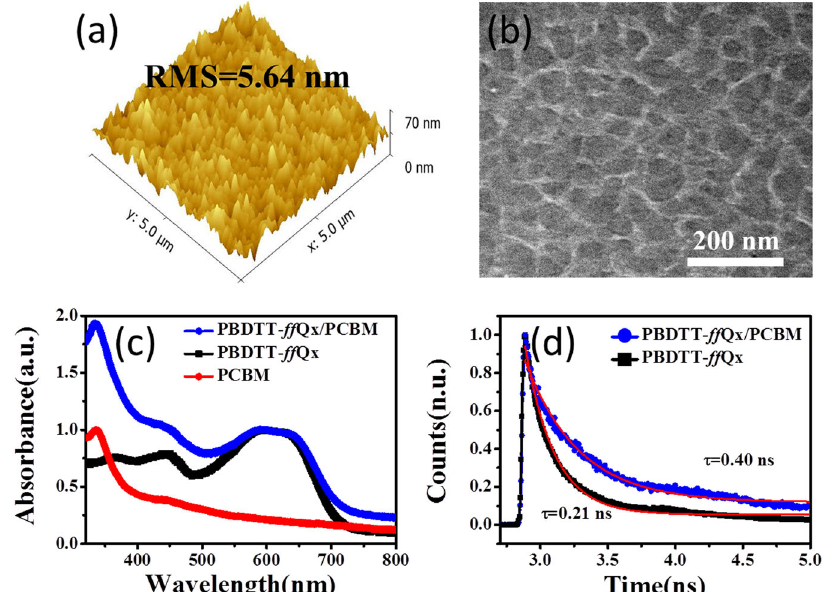
Fig. 2 a AFM and b TEM images of PBDTT- ff Qx/PCBM BHJ thin fi lm. c UV – vis absorption spectra of PBDTT- ff Qx (black), PCBM (red), and PBDTT- ff Qx/PCBM BHJ (blue) thin fi lms, respectively. d The PL time decay traces of PBDTT- ff Qx and PBDTT- ff Qx/PCBM BHJ thin fi lms at λ PL = 703 nm with the exponential fi ts ( y ¼ y 0 þ A e (cid:2) x = τ ), of which the lifetime is 0.21 and 0.40 ns,